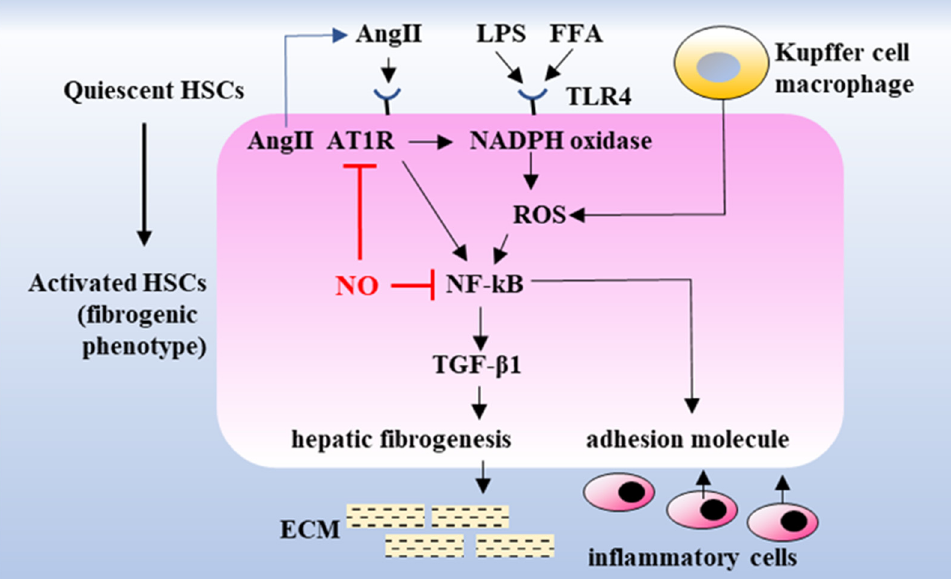
Figure 9. Proposed scheme of the molecular mechanism of NASH progression and its prevention by NO. HSCs are generally quiescent pericytes, whereas, upon stimulation by LPS and/or FFAs, they transdifferentiate into a fibrogenic phenotype that secretes ECM, leading to hepatic fibrosis via transcription factor-mediated signal transduction involving the Ang II-AT 1 R pathway, which also induces the expression of adhesion molecules, leading to further inflammatory processes. NO inhibits the AT 1 R and NF- κ B-mediated upstream pathway of the inflammatory process. NASH, nonalcoholic steatohepatitis; HSCs, hepatic stellate cells; Ang II, angiotensin II; AT 1 R, angiotensin II type 1 receptor; LPS, lipopolysaccharide; FFAs, free fatty acids; NO, nitric oxide; NADPH, nicotinamide adenine dinucleotide phosphate; TLR4, Toll-like receptor 4; ROS, reactive oxygen species; NF- κ B, nuclear factor-kappa B; TGF- β 1, transforming growth factor-beta 1; ECM, extracellular matrix. Vascular endothelial function in SHRSP5/Dmcr rats is further impaired by HFC diet intake, which causes atherosclerosis and hypertension [8]. Therefore, increased aortic